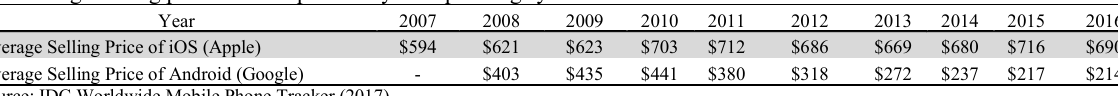
The average selling price of smartphones by the operating